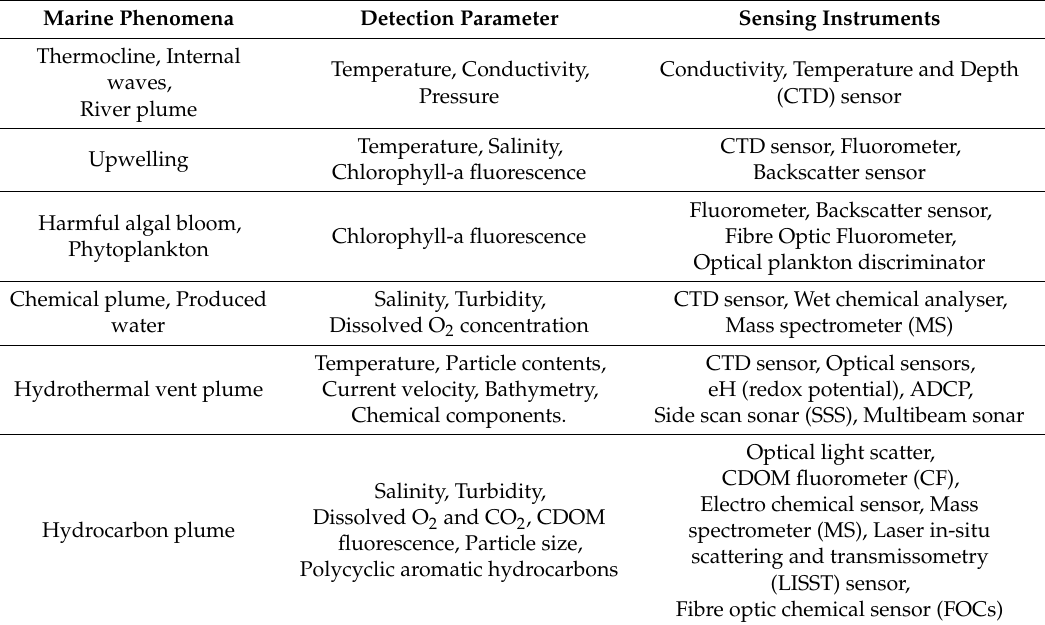
Table 2. Sensors to be integrated with an autonomous underwater vehicle (AUV) for sampling the physical, biological and chemical features discussed in this